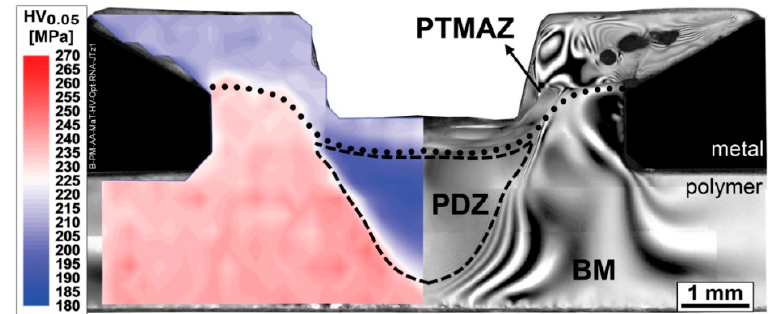
Figure 6. Overlay of a microhardness map (left) on a CP-TLOM micrograph of the PEI-aluminum F-ICJ joint from Figure 5. Dotted lines are the boundaries of the polymer thermo-mechanically-affected zone (PTMAZ); dashed lines are the boundaries of the plastically deformed zone (PDZ). Base material (BM) was labeled for the unaffected PEI region. For processing conditions see Table 1. Adapted from [19].